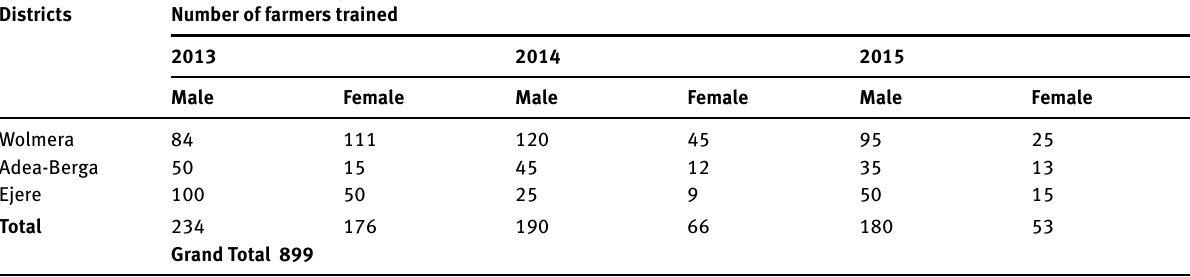
Table 1: Number of farmers trained on seed production, 2013–2015 Districts Number of farmers